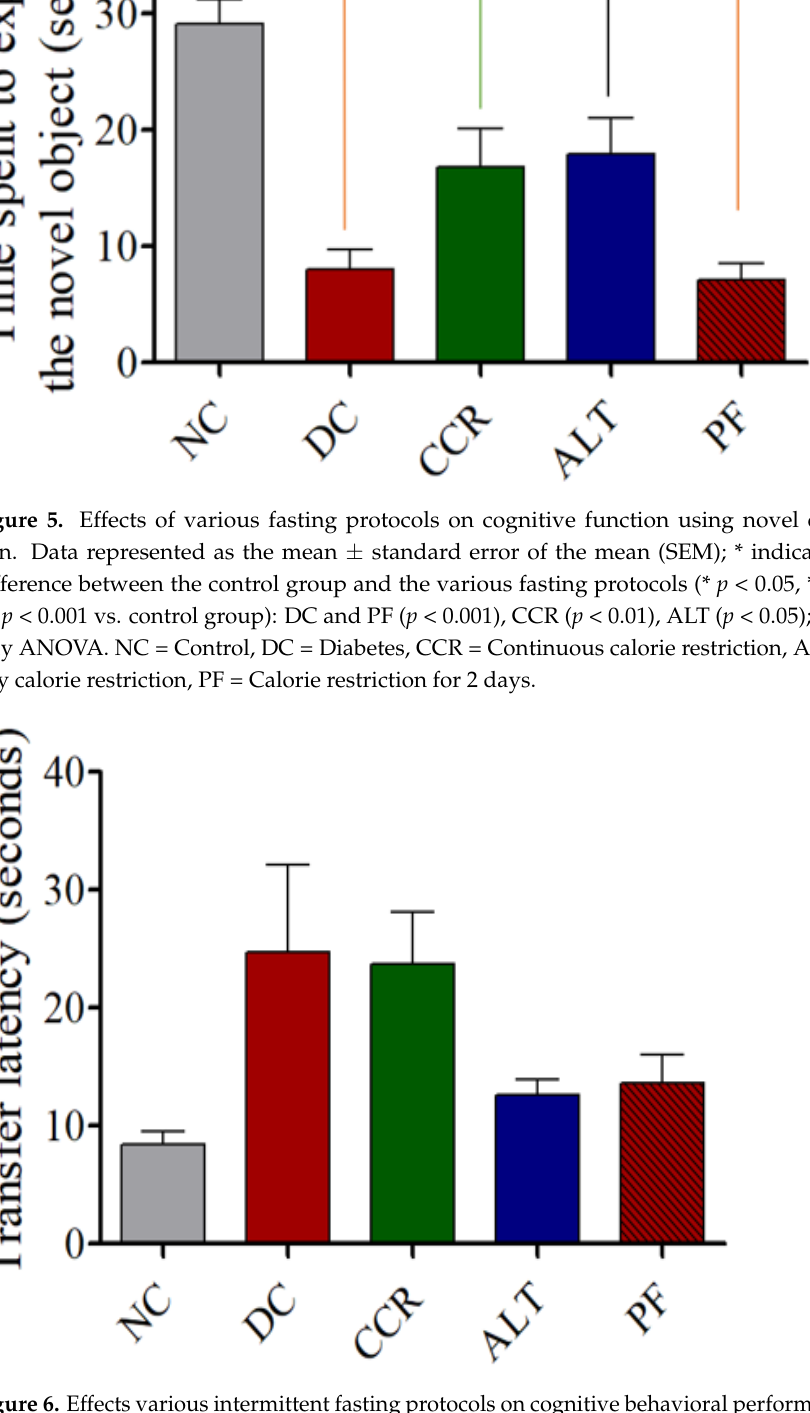
Figure 6. Effects various intermittent fasting protocols on cognitive behavioral performance of control and hyperglycemic rats in the elevated plus-maze test. Data represent the mean ± SEM of the transfer latency time. NC = Control, DC = Diabetes, CCR = Continuous calorie restriction, ALT = Alternate day calorie restriction, PF = Calorie restriction for 2 days.